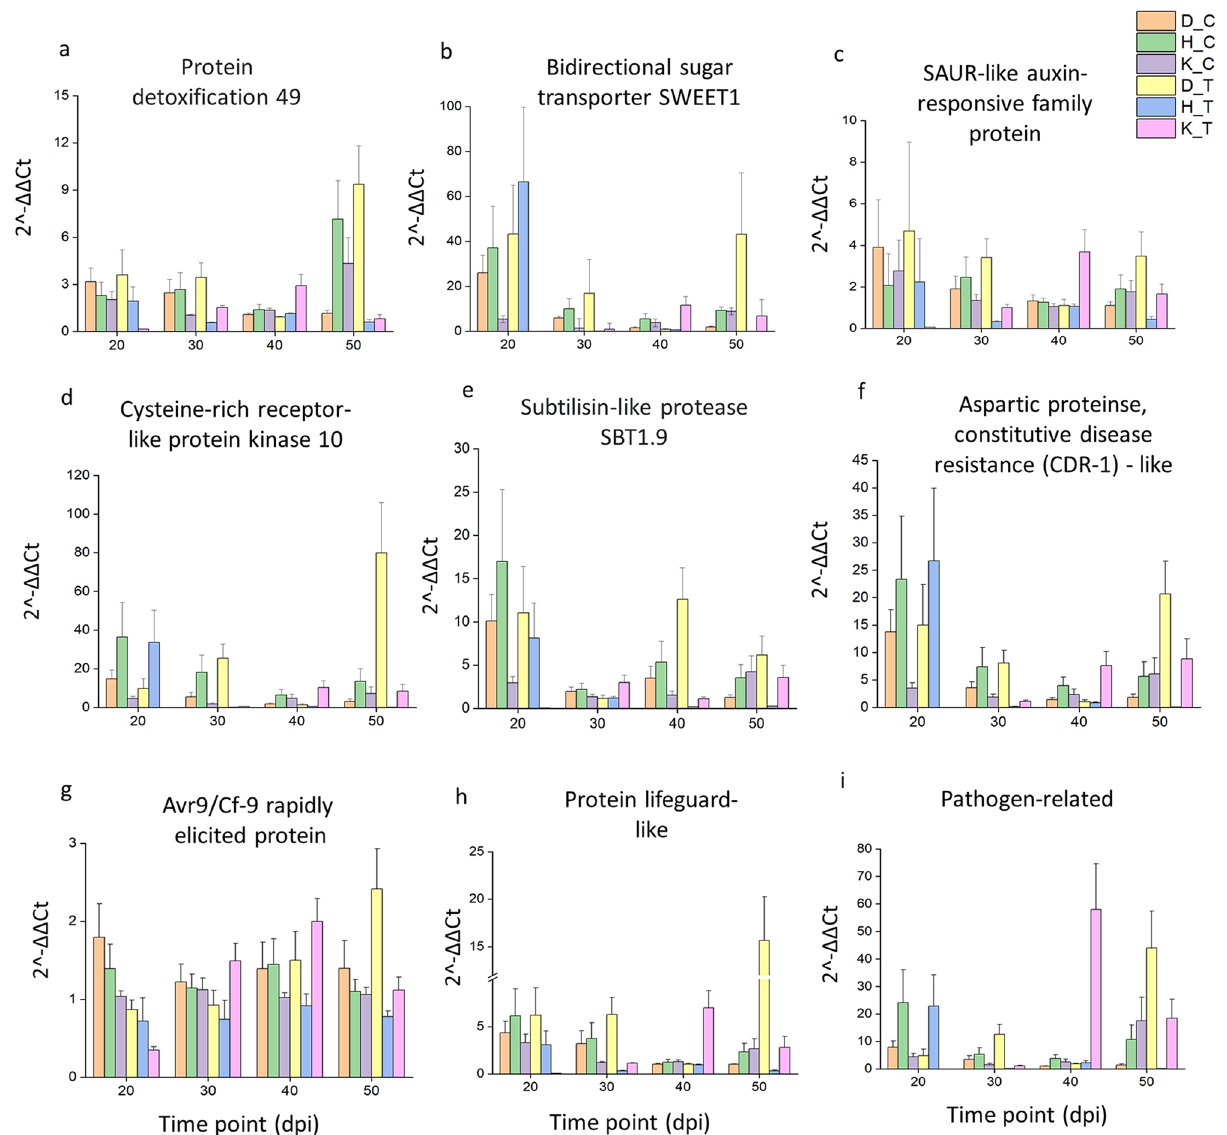
Figure 2. The qRT-PCR analysis of important genes across different time points in three genotypes. D_C, D05253 control; D_T, D05253 treated; H_C, PBA HatTrick control; H_T, PBA HatTrick treated; K_C,